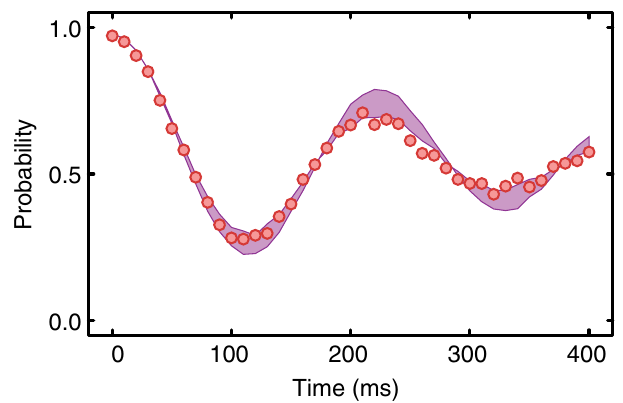
FIG. 6. Rabi oscillations on the clock transition with π -pulse length of 110 ms. Each point is probed directly after stabilizing the clock laser with a feedback sequence as described in the main text. The shaded area denotes Monte Carlo